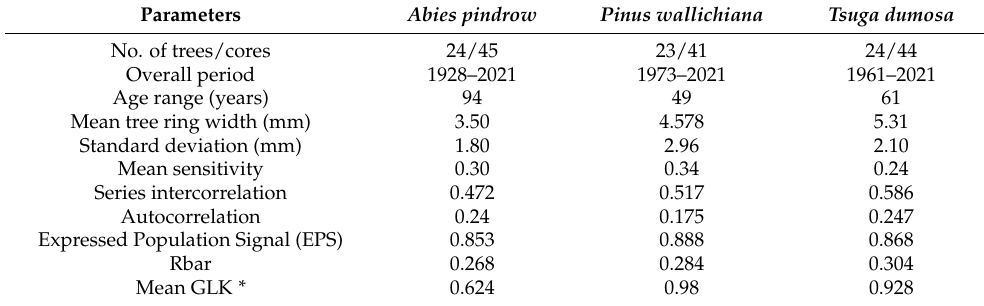
Table 2. Dendrological parameters of Abies pindrow , Pinus wallichiana , and Tsuga dumosa in Jiri,